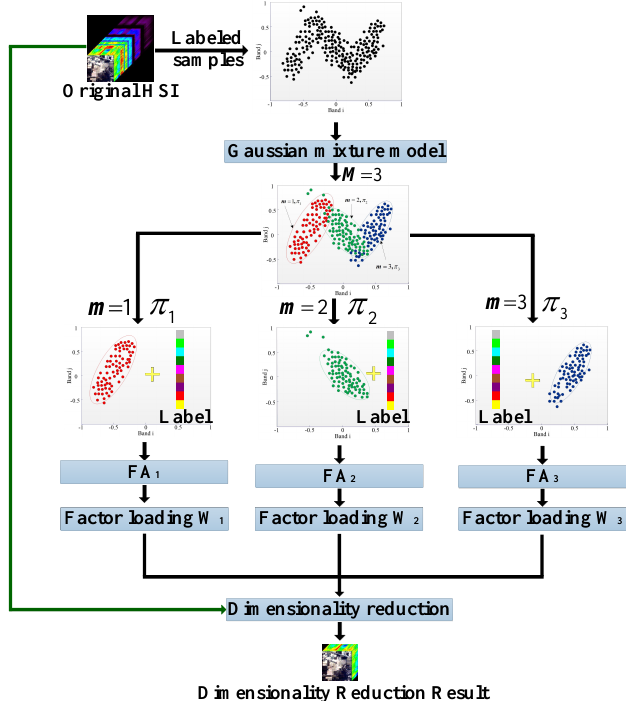
Figure 4. The schematic of the SMFA corresponding to Figure 1b.